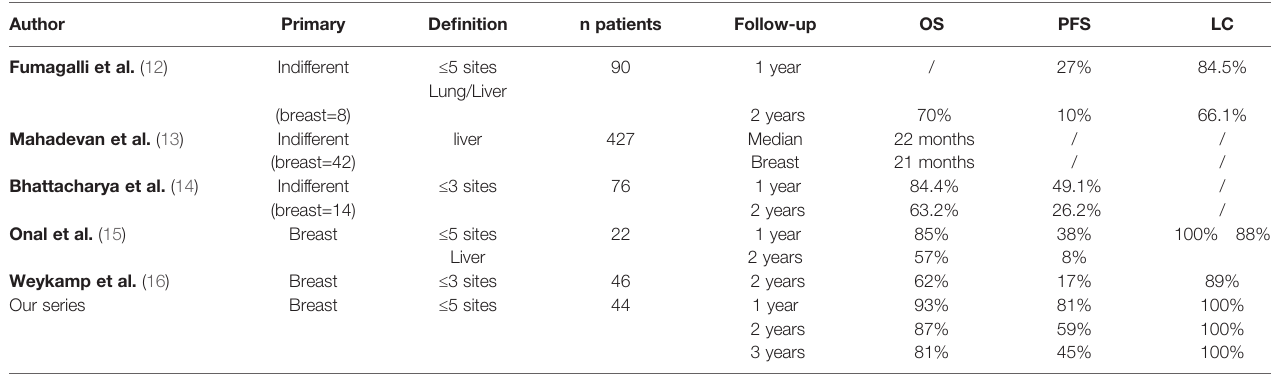
TABLE 4 | Review of the literature of retrospective series about SBRT for oligometastases of breast cancer.